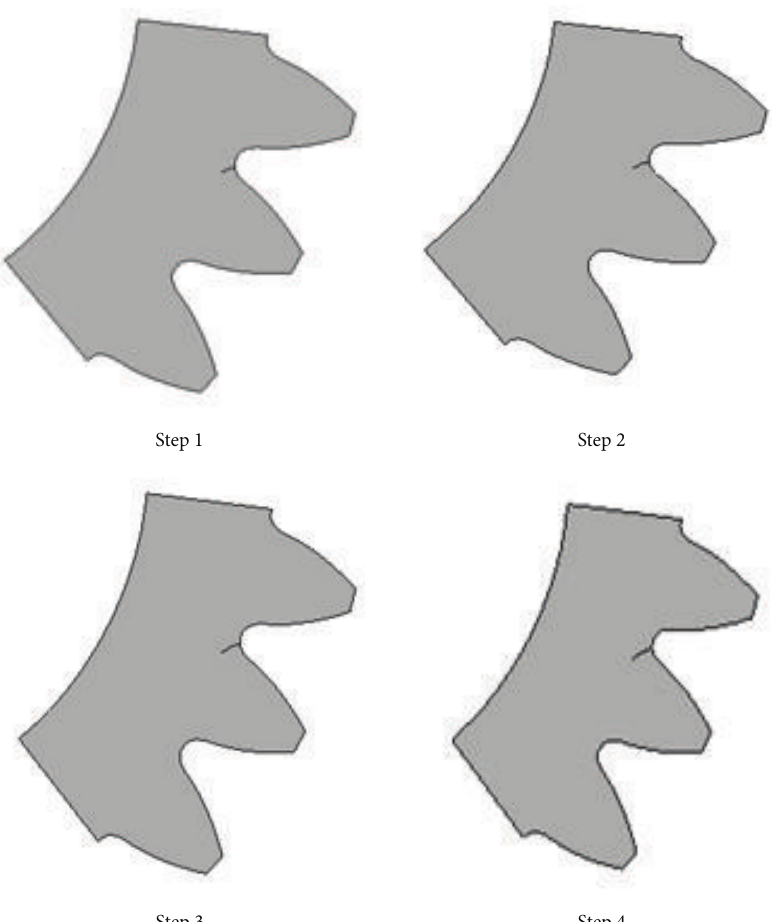
Figure 8: The simulations of fatigue crack extensions of the example